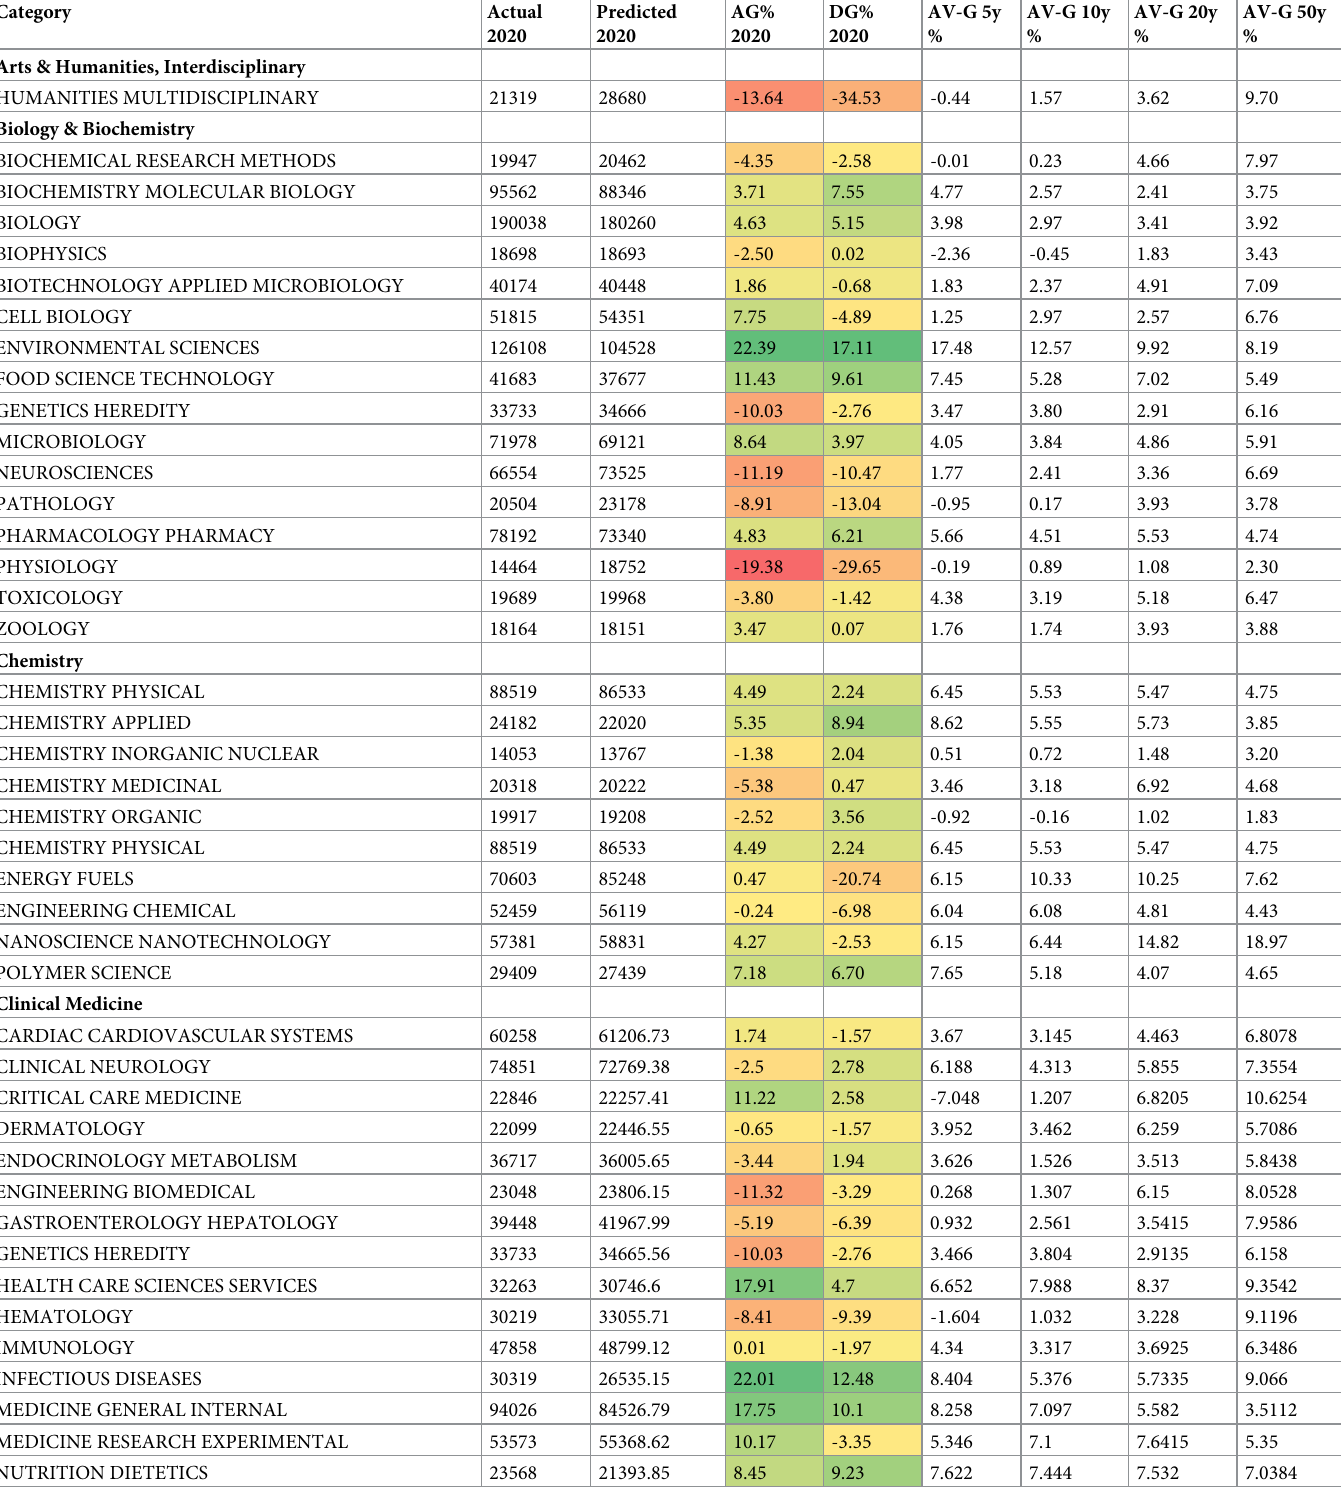
Table 1. Statistics of temporal trends of productivity in various domains of science.